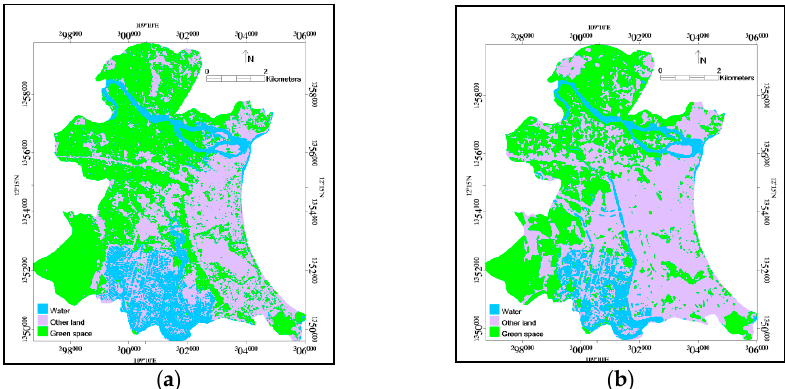
Figure 1. Distribution of UGS in urban core. ( a ) UGS in 2007; ( b ) UGS in 2017.